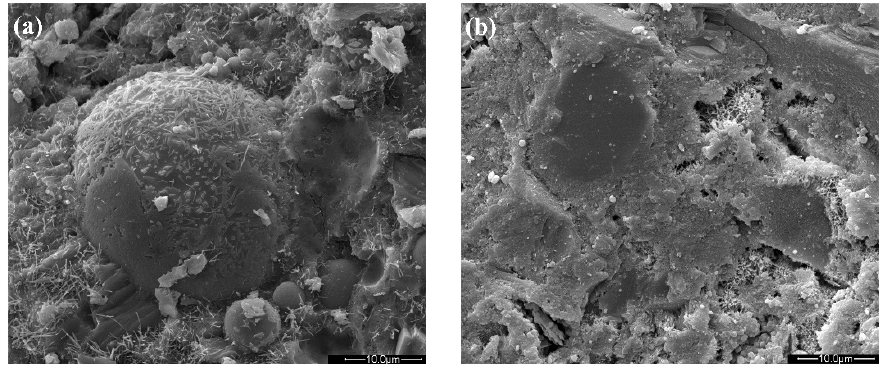
Figure 4. SEM observation of ( a ) FA and ( b ) GGBS in the hardened pastes (90 days) corresponding to the concrete with an equal 28-day strength grade.